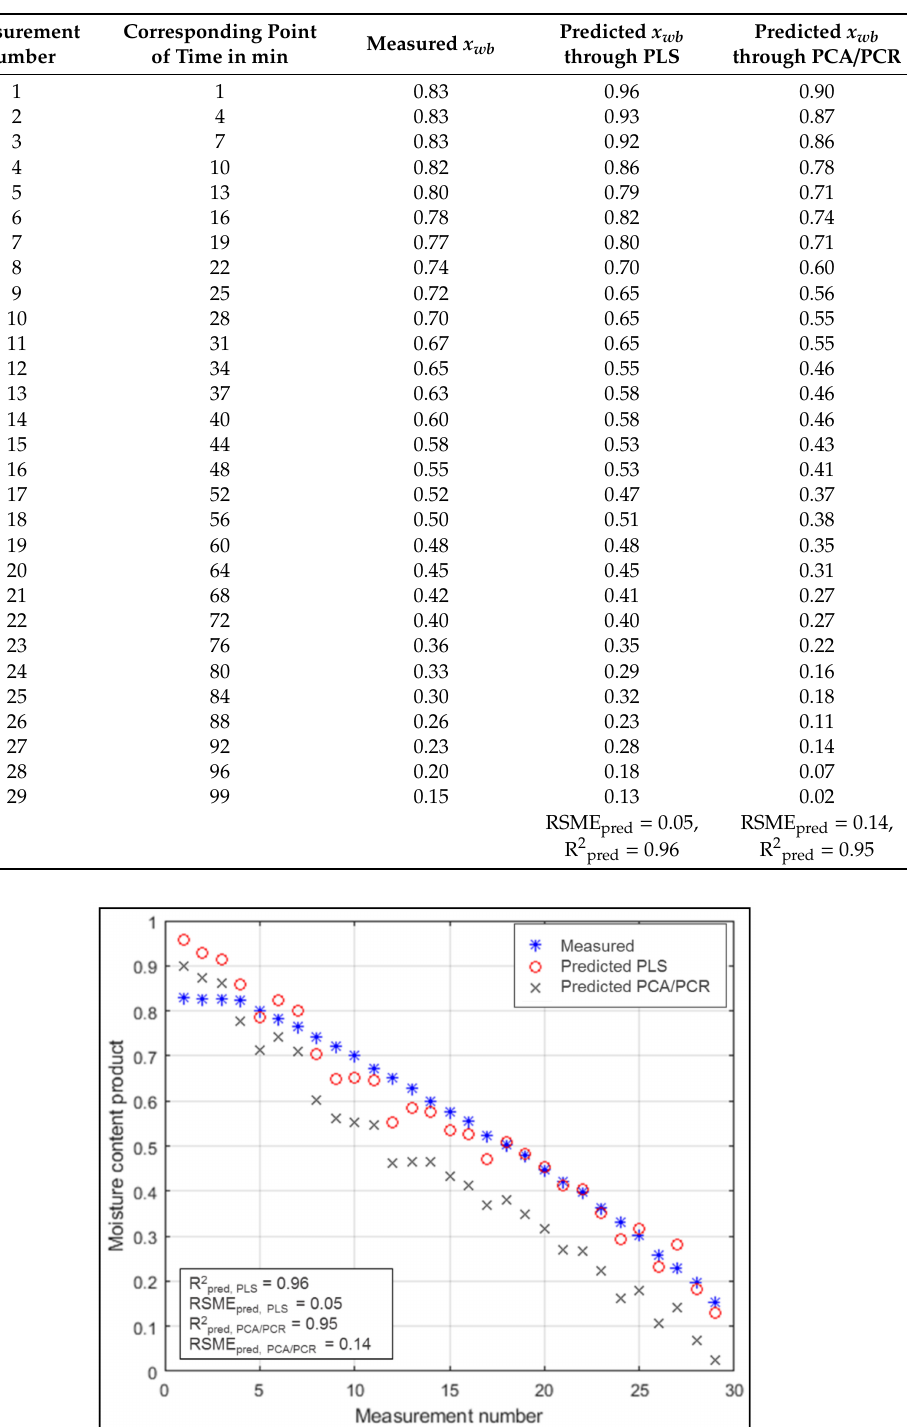
Table 2. Results of x wb prediction.